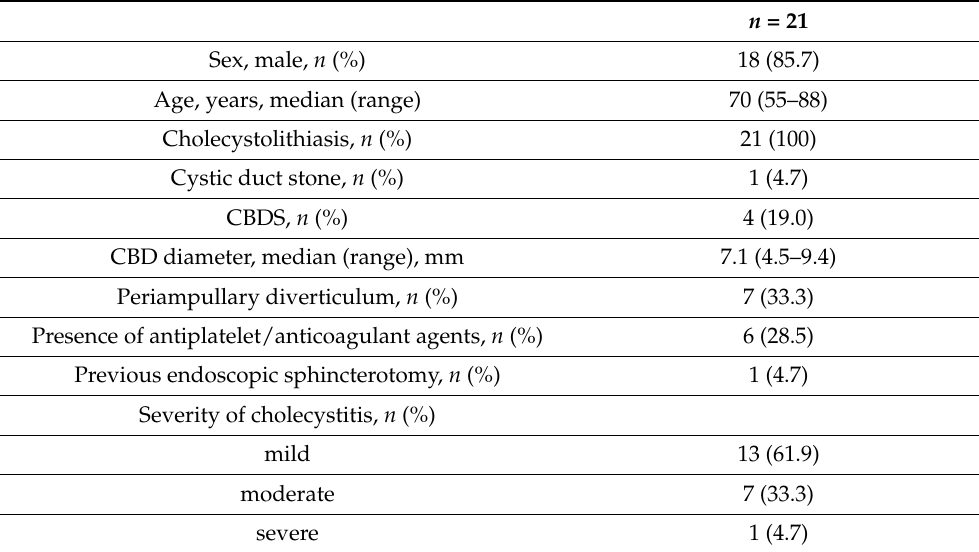
Table 1. Patient